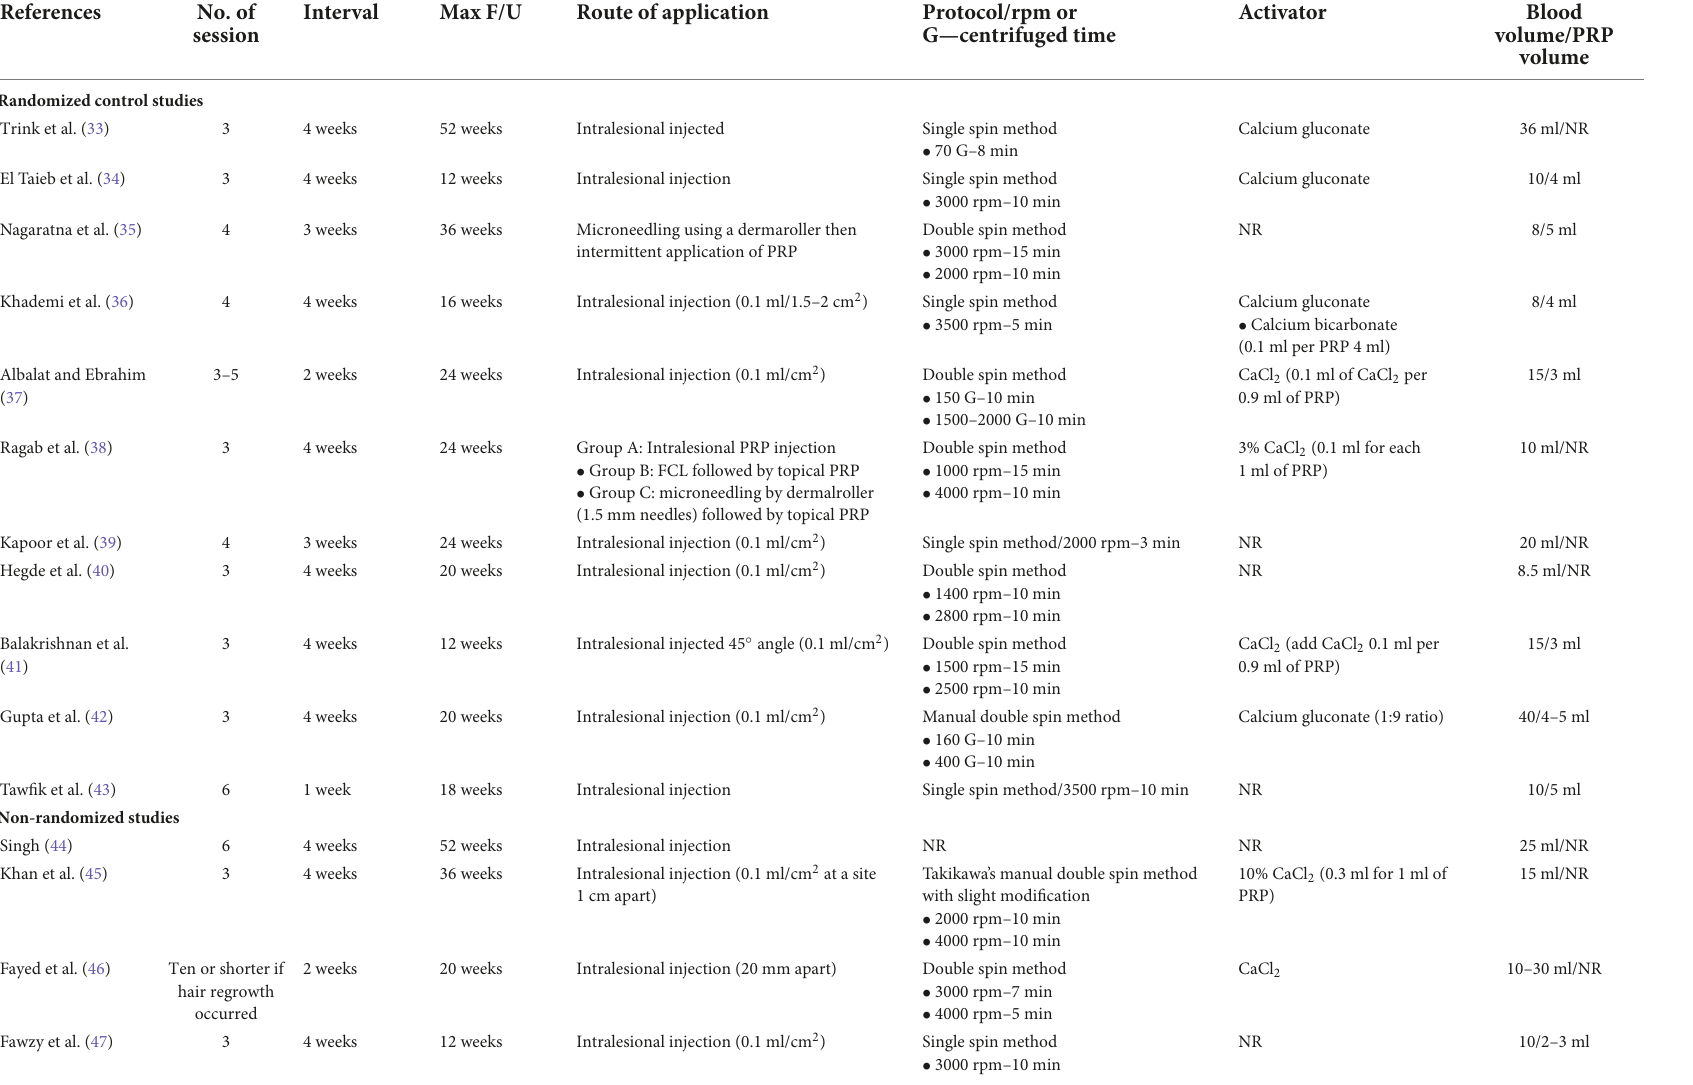
TABLE 3 Platelet-rich plasma preparation protocols of included alopecia areata